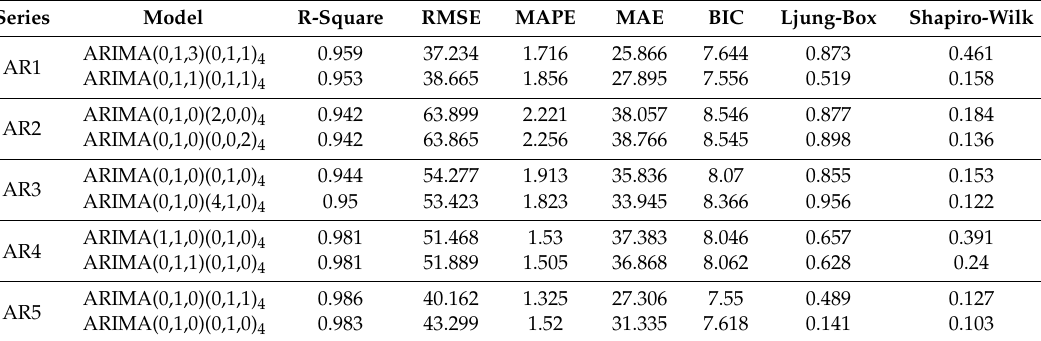
Table 5. Model fit statistics and residual